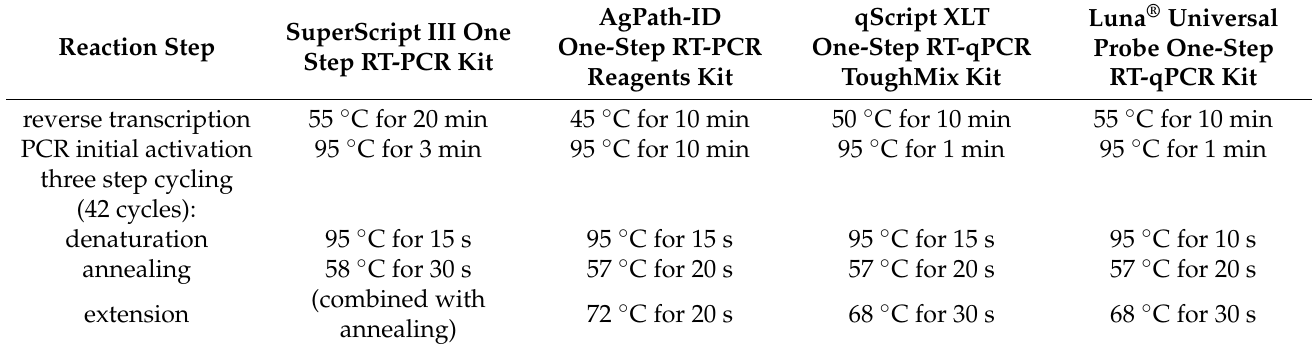
Table 1. Thermal profiles of the RT-PCR chemistry used in this